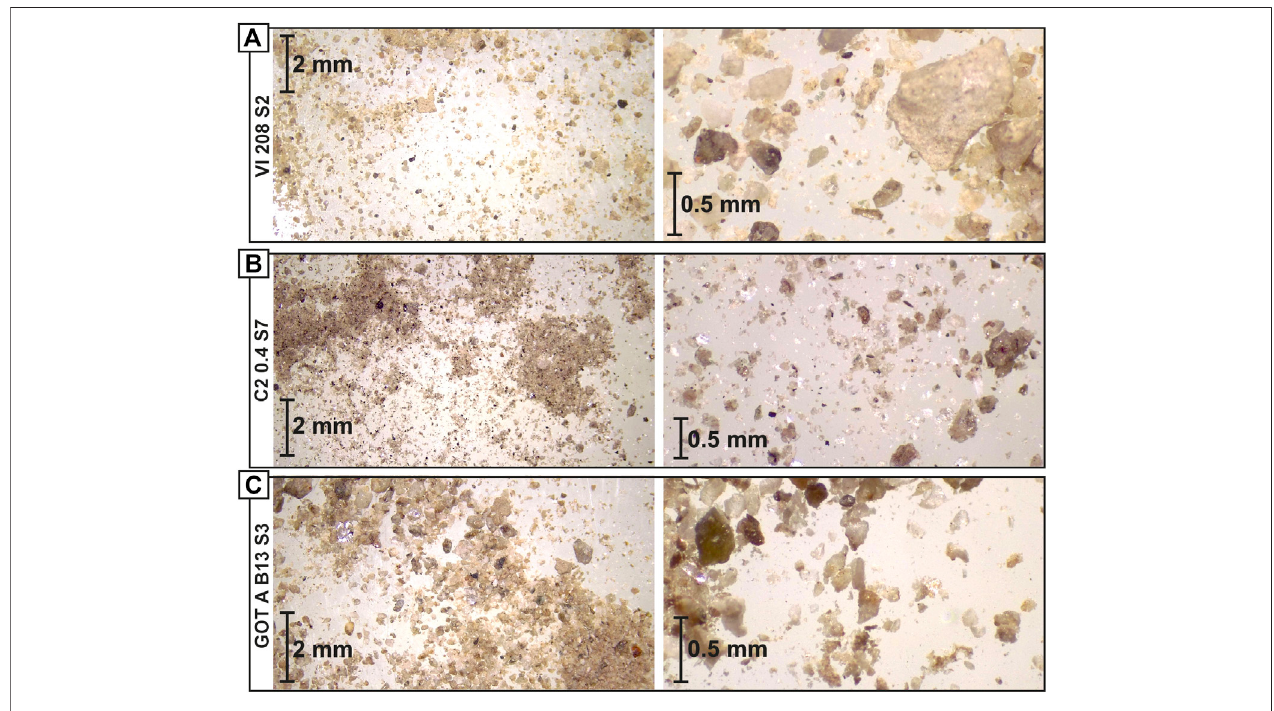
FIGURE 10 | Photos taken under magni fi cation of three samples disaggregated in SELFRAG, results shown in Figure 11 . (A) Sample from Marnoso-Arenacea Formation (B) sample from Gottero Formation and (C) sample from Castagnola Formation. For data Supplementary Table S1 .